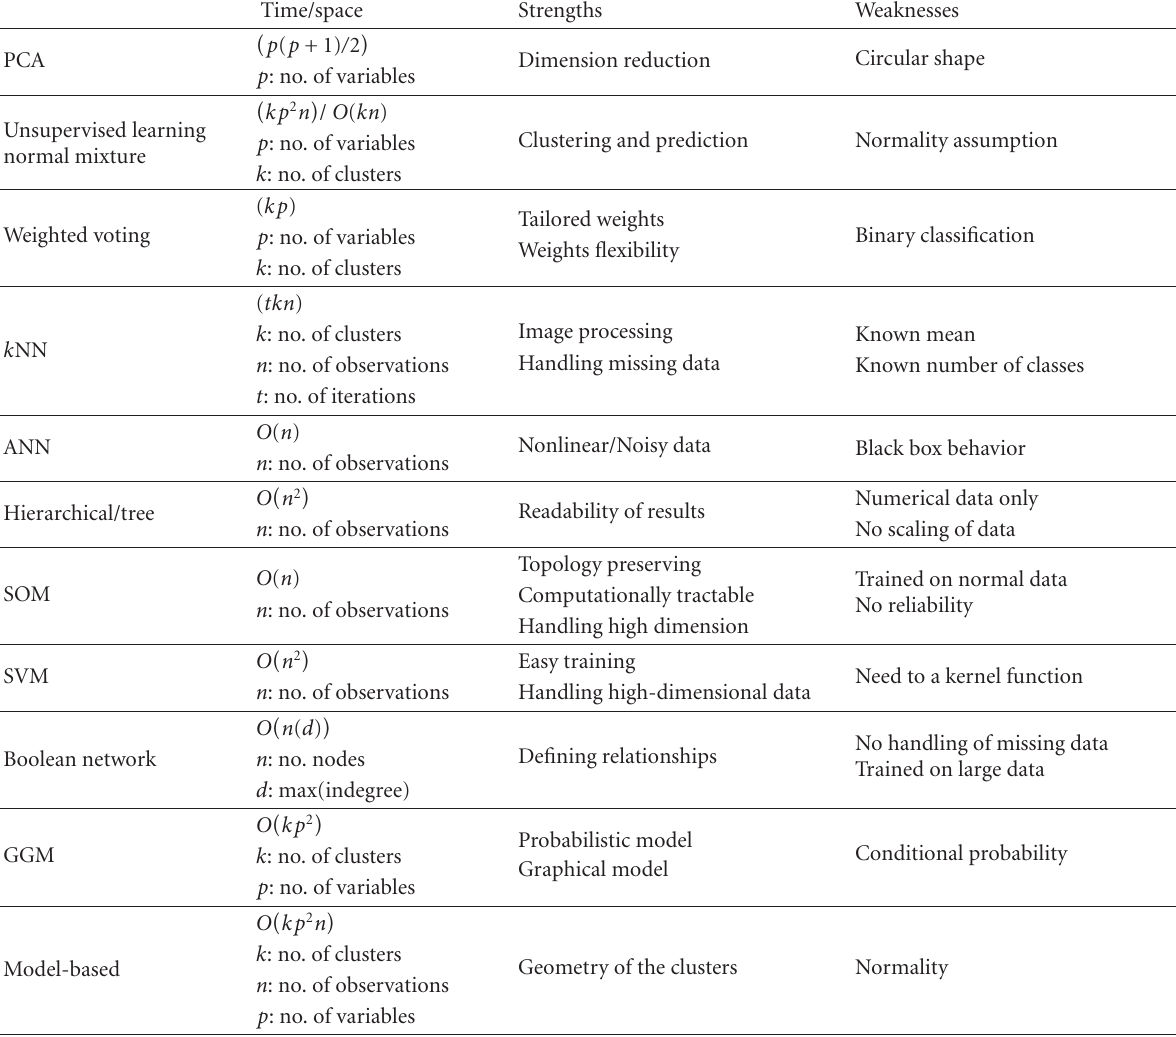
Table 2. Summary of the properties of the most commonly applied algorithms for data